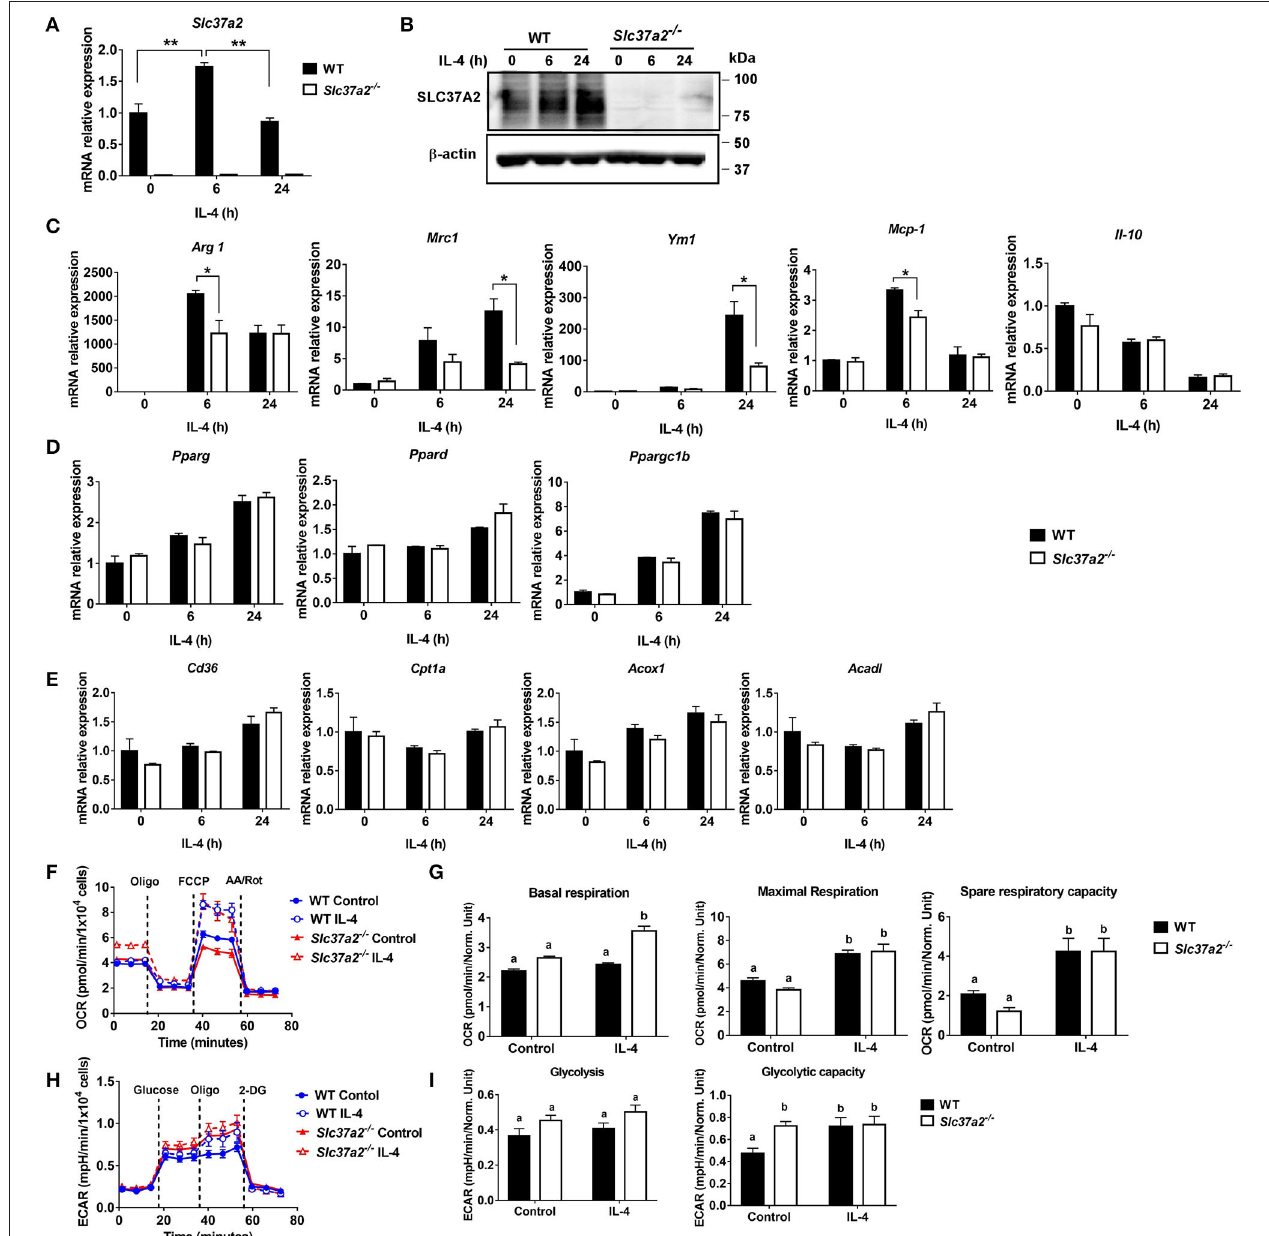
FIGURE 6 | SLC37A2 deficiency impairs IL-4-induced macrophage activation in vitro . (A,B) SLC37A2 expression in WT and Slc37a2 − / − bone marrow-derived macrophages (BMDMs) stimulated with 20ng/ml IL-4 for 0-24h. (A) relative transcript expression and (B) protein expression of SLC37A2 measured by qPCR and western blotting, respectively. (C) Relative transcript level of macrophage alternative activation markers, including arginase − 1 (Arg), mannose receptor, type I (Mrc1), Ym1, IL-10, and chemokine MCP-1, in WT and Slc37a2 − / − BMDMs stimulated with 20ng/ml IL-4 for 0-24h. (D,E) The relative transcript level of PPARs and genes encoding transporters or enzymes involved in fatty acid uptake or β -oxidation in WT and Slc37a2 − / − BMDMs stimulated with 20ng/ml IL-4 for 0-24h. (F,G) Seahorse analysis of oxygen consumption rate (OCR) in WT and Slc37a2 − / − BMDMs treated with or without 20ng/ml IL-4 for 24h. (H,I) Seahorse analysis of extracellular acidification rates (ECAR) in WT and Slc37a2 − / − BMDMs treated with or without 20ng/ml IL-4 for 24h. Data are representative of two independent experiments with three samples per group (mean ± SEM). * p < 0.05; ** p < 0.01; unpaired, two-tailed Student’s t -test (A,C,D,E) . Bars with different letters denote significant among groups ( p < 0.05); two-way ANOVA with post hoc Tukey’s multiple comparisons test (G,I) .